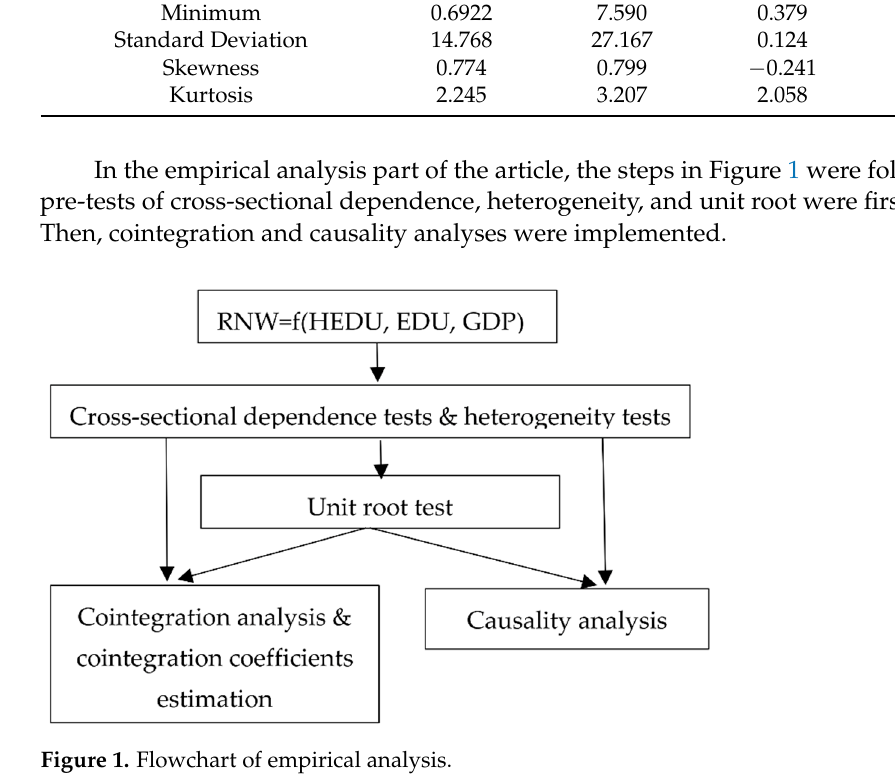
Figure 1. Flowchart of empirical analysis.